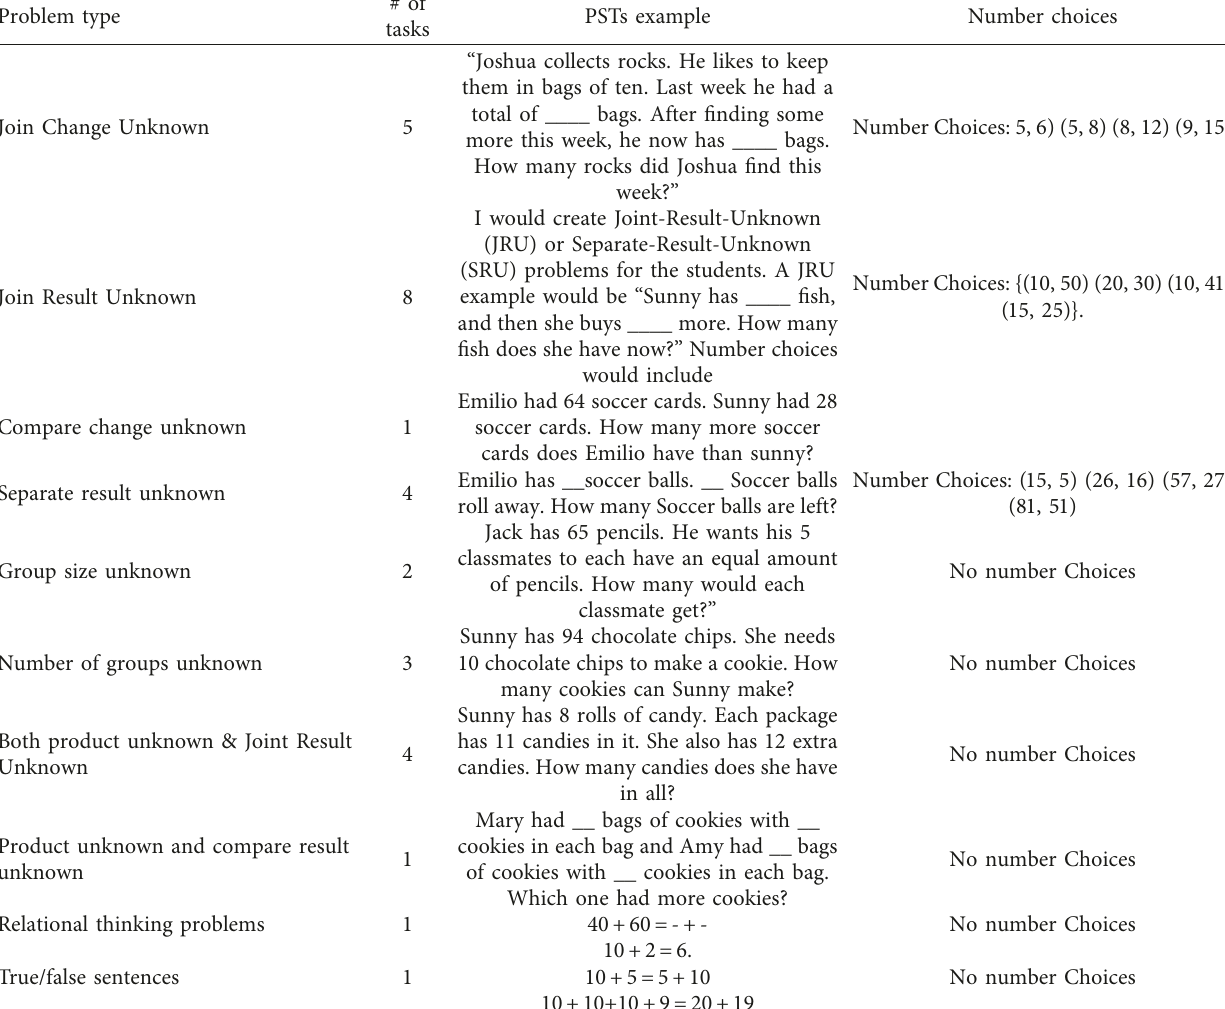
Table 7: Nature of tasks selected during the Inquiry into Student Thinking